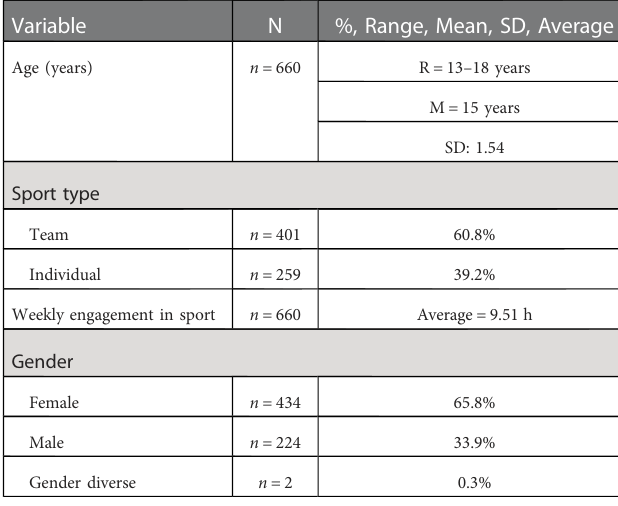
Univariate regression results of the effect of covariates on each dependent variable are shown in Supplementary Material . Two independent variables had a statistically signi fi cant effect on increased odds of supplement use among adolescent athletes: